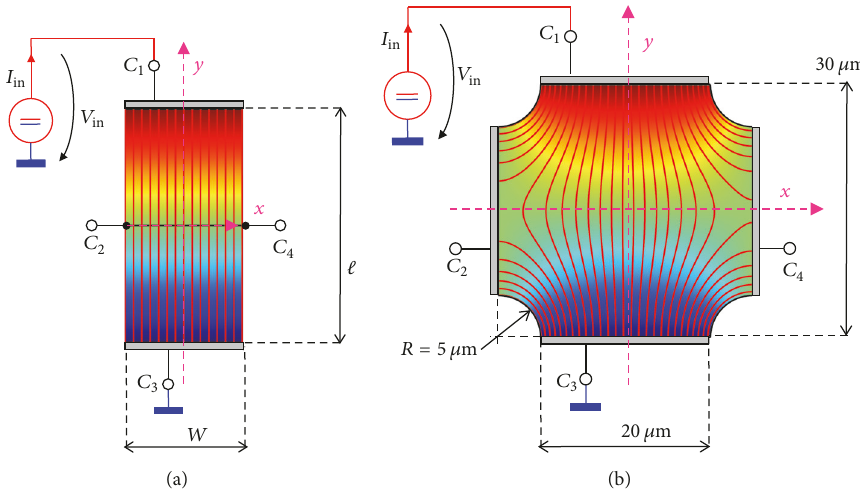
Figure 2: (a) Rectangular device with large supply contacts 𝐶 1 – 𝐶 3 and point-sized sense contacts 𝐶 2 – 𝐶 4 with potential distribution and current streamlines at 𝜎 𝑥𝑦 = 1 MPa. At zero stress it has two squares input resistance ℓ/𝑊 = 2 and according to (4) this gives 𝐺 𝐻0 = 0.93006 . (b) Cross-shaped device with large supply contacts 𝐶 1 – 𝐶 3 and large sense contacts 𝐶 2 – 𝐶 4 with potential distribution and current streamlines at 𝜎 𝑥𝑦 = 1 MPa. At zero stress it has 1.0359 squares input resistance and according to (4) this gives 𝐺 𝐻0 = 0.45364 . The plots were obtained by a finite element simulation (FEM) with commercial software code COMSOL MULTIPHYSICS. This FEM simulation gives a stress output signal of device (a) which differs only 0.4 ppm from 𝑉 out = 𝑅 sh 𝐼 in (𝜋 12 −𝜋 11 )𝜎 𝑥𝑦 𝐺 𝐻0 from [2]. An FEM calculation of device (b) gives an